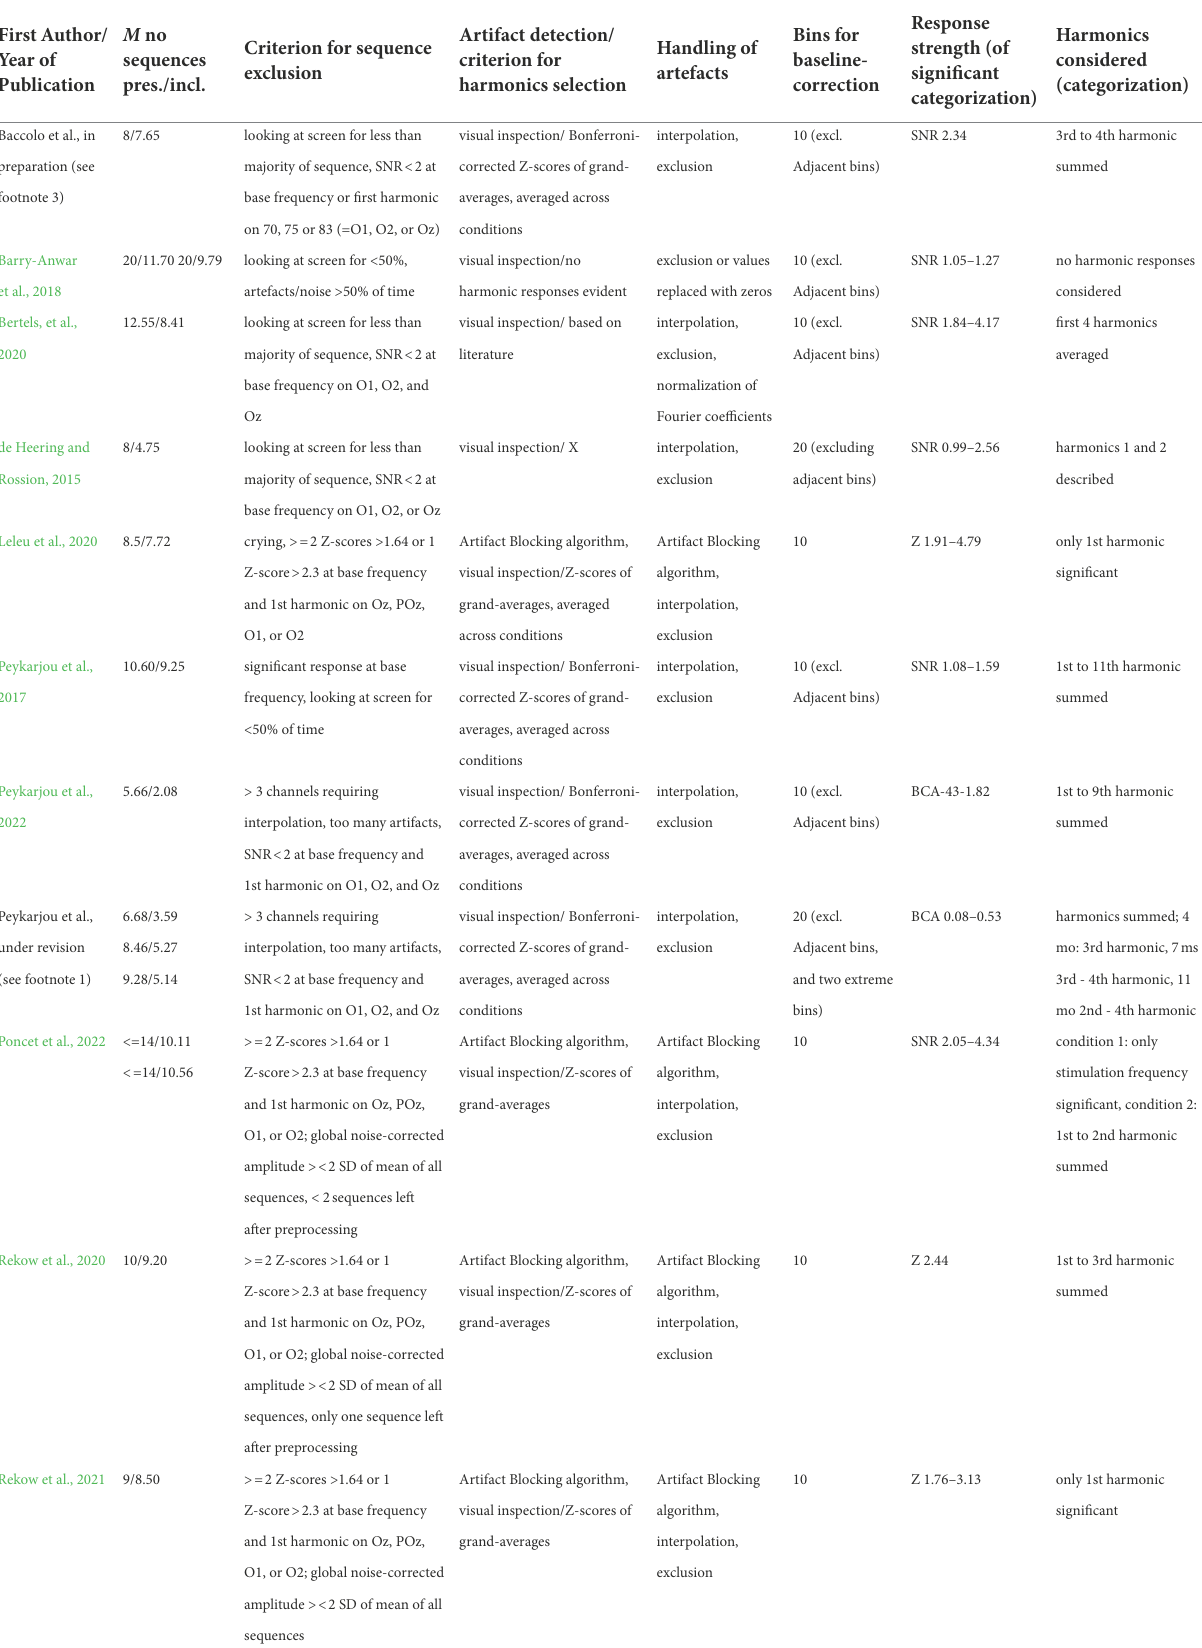
TABLE 2 Analysis decisions of studies included in the systematic